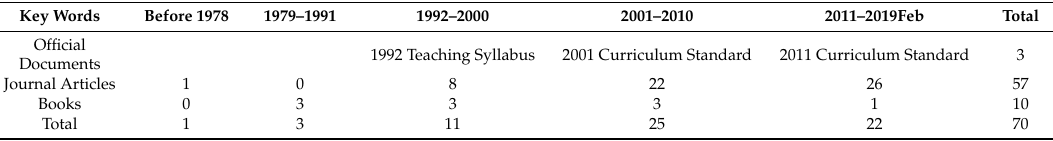
Table 2. Sources of Literature Reviewed in this